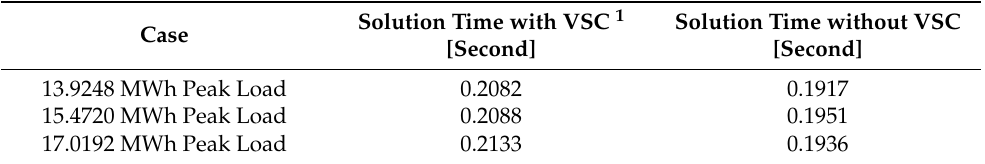
Table 2. Scalability Test.